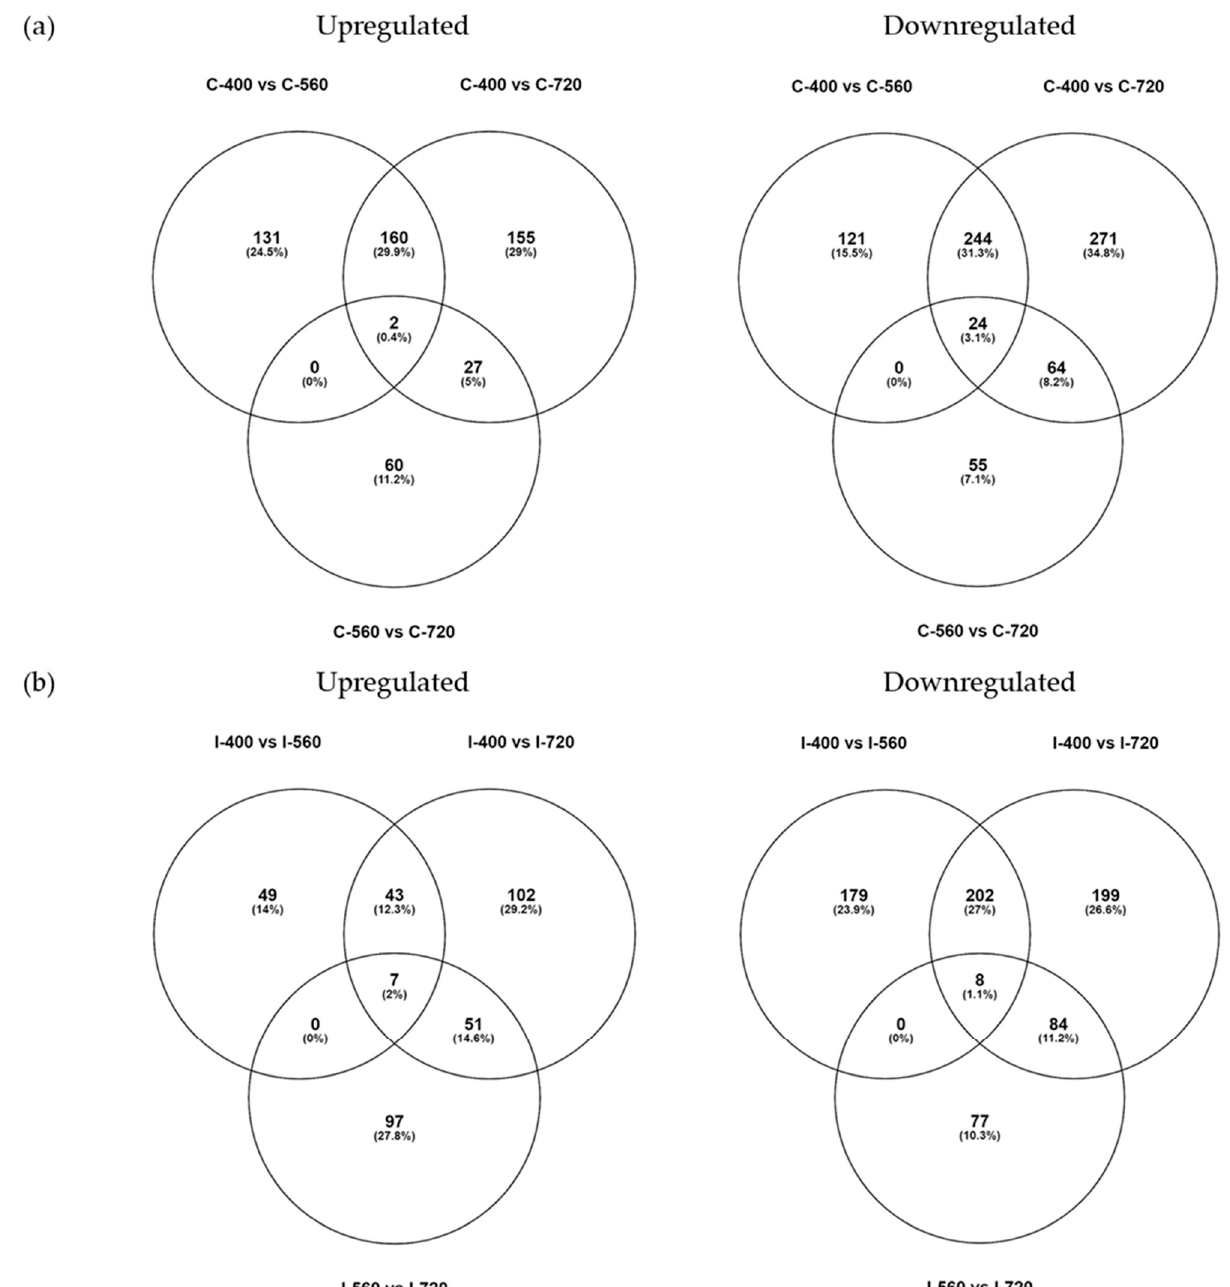
Figure 4. Comparison of differentially expressed genes. ( a ) Clivus ( Populus alba × P. glandulosa , a poplar clone hybrid); and ( b ) I-476 ( Populus euramericana ). Upregulated-log2 fold change ( ≥ 2); Downregulated-log2 fold change ( ≤− 2). Each species was treated with three different concentrations of CO 2 . C-400, Clivus CO 2 400 ppm; C-560, Clivus CO 2 560 ppm; C-720, Clivus CO 2 720 ppm; I-400, I-476 CO 2 400 ppm; I-560, I-476 CO 2 560 ppm; I-720, I-476 CO 2 720 ppm.